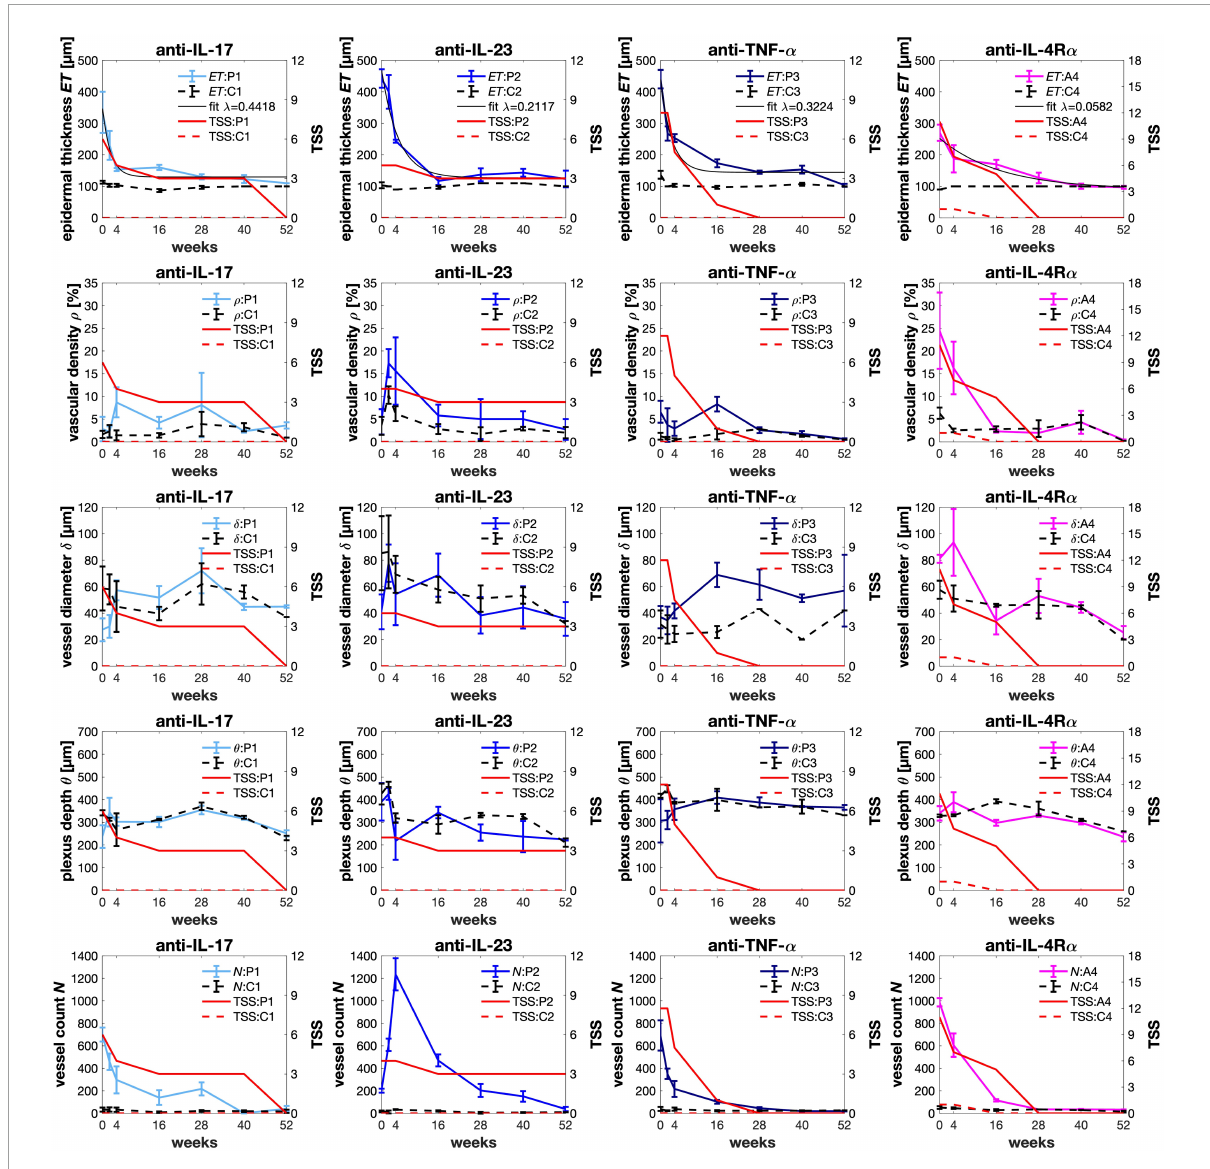
FIGURE4 Monitoring therapy response using optical coherence tomography (OCT). In psoriasis (P1–P3) and atopic dermatitis (A4), the epidermal thickness ( ET ) was fitted to calculate the exponential decay rate or response rate λ . The vessel count N was calculated using ImageJ (U.S. National Institutes of Health, Bethesda, MD, USA). After 52 weeks of treatment, we observed a full normalization of the increased epidermal thickness and the vessel count. The vascular parameters such as vascular density (cid:37) , vessel diameter δ , and plexus depth θ were calculated by using the proprietary VivoSight vessel analysis software (Michelson Diagnostics, Maidstone, Kent, UK). Prior to treatment, the vascular density in inflamed skin was higher than in the control areas. Interestingly, we observed an upward shift of the plexus depth and smaller vessel diameters in psoriatic skin in comparison to the control at baseline. Eczematous skin showed larger vessel diameters. As a potential sign of therapy response, the vascular parameters normalized during therapy course. For correlation, the total sign score (TSS) was used to clinically assess the target lesions and their control sites. For psoriasis, erythema E , induration I , and desquamation D were assessed using a 5-point scale (0–12). For atopic dermatitis, six clinical signs including erythema E , papulation I , excoriation Ex , lichenification Li , crusting C , and dryness Dr were graded using a 4-point scale